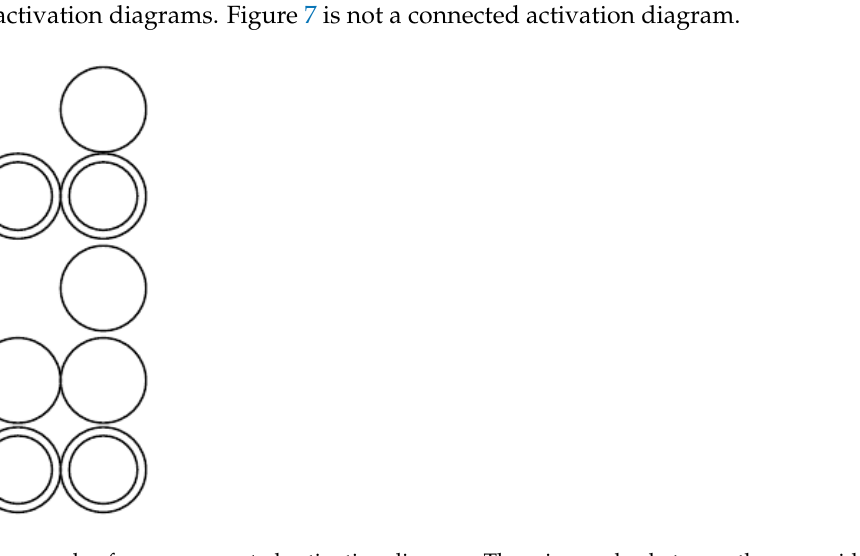
Figure 7. An example of a non-connected activation diagram. There is no edge between the pyramid below and the pyramid